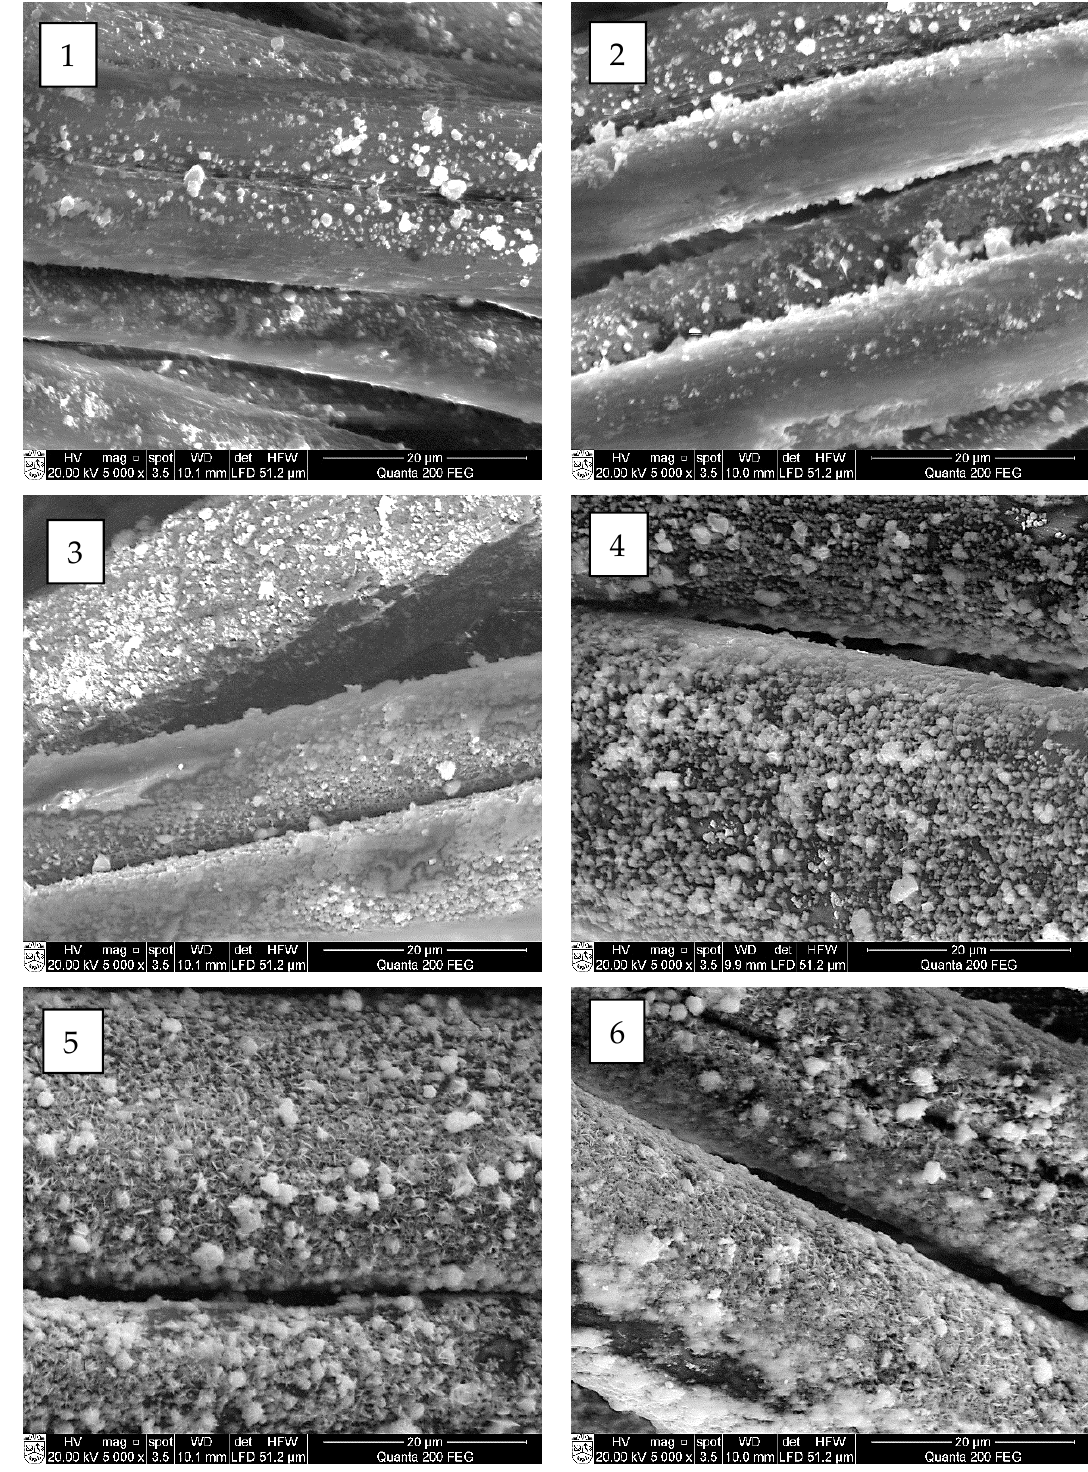
Figure 7. SEM images of copper selenide-coated PAN fibers after different numbers of treatment cycles: ( 1 ) first (mag. 5000×); ( 2 ) second (mag. 5000×); ( 3 ) third (mag. 5000×); ( 4 ) fourth (mag. 5000×); ( 5 ) fifth (mag. 5000×); and ( 6 ) sixth (mag. 5000×).